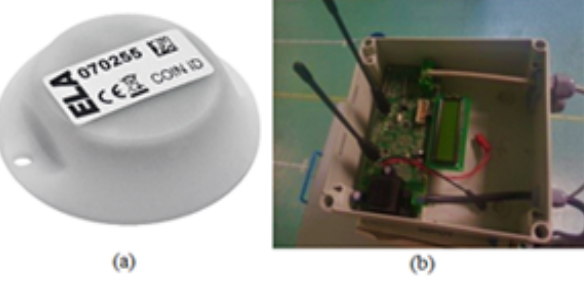
Figure 8. ( a ) RFID tag and ( b ) RFID reader.